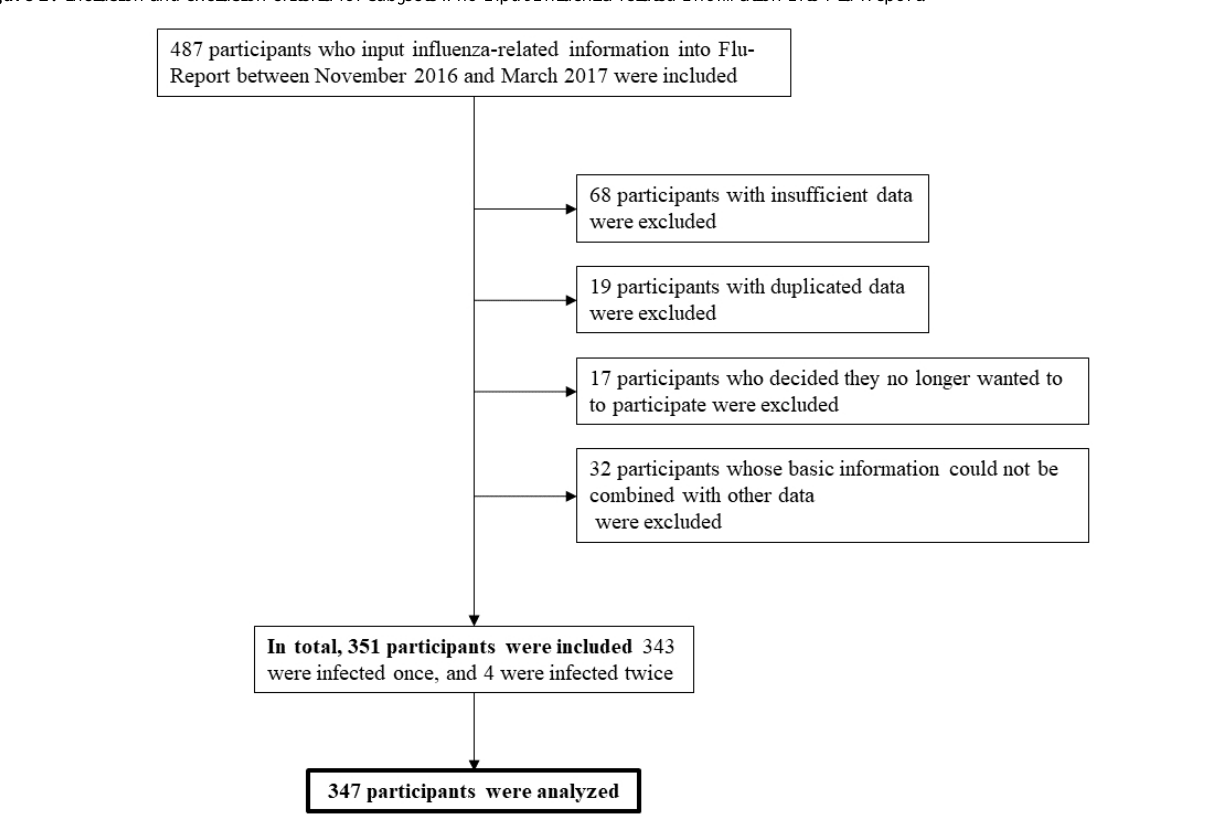
Figure 2. Inclusion and exclusion criteria for subjects who input influenza-related information into